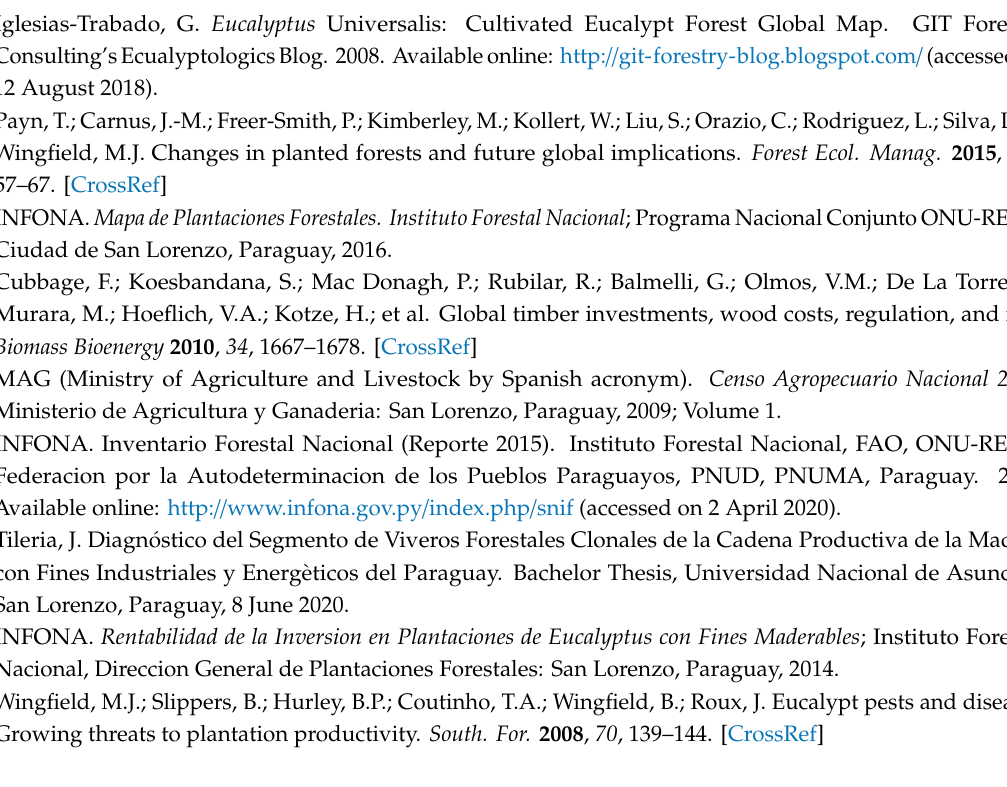
Figure S1: Phylogram based on the analysis of ITS region for Austropuccinia rust found in eucalypts leaves in Paraguay. Bootstrap confidence values (1000 replicates) are indicated above the internodes. The tree is rooted in Dasyspora